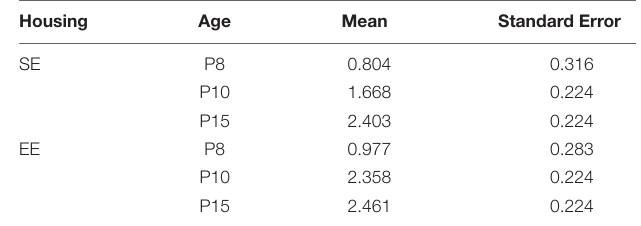
TABLE 5 | BDNF protein